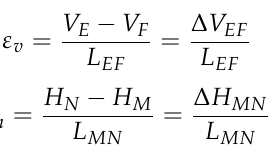
Figure 8. Schematic diagram of deformation calculation (A, B, C, E, F, M, N is the initial position of the point, and A’, B’, C’, E’, F’, M’, N’ is the position after deformation). 4. Numerical Simulation of Shafts Stability and Surface Deformations 4.1. Numerical Model Setup To estimate the shaft stability and surface deformation induced by underground mining transferred from open-pit mining precisely, the model scope is appropriately expanded from the mining area to reduce the influence of boundary effect. Finer meshing was assigned to the research domain where the shafts, faults, surface, and orebody are located. Finally, a three-dimensional numerical model was established with a length of 1700 m (WE), a width of 1350 m (NS), and an average height of 1000 m, including a total of 3.6 million zones and 2 million nodes. The three-dimensional model is shown in Figure 9.